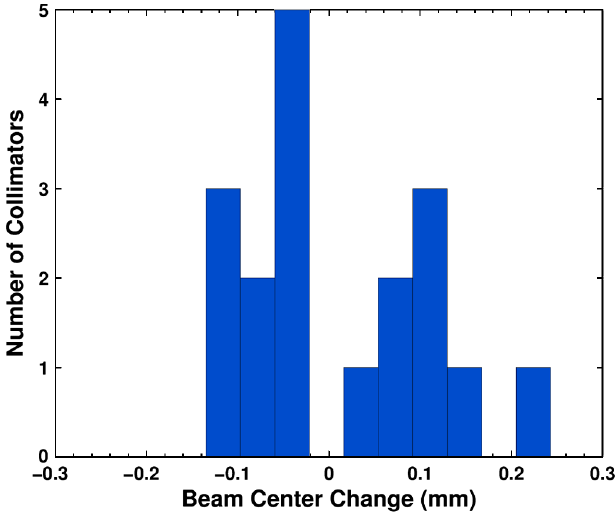
FIG. 12. Change in the beam centers for the IR3 B1 and B2 collimators over four months of LHC